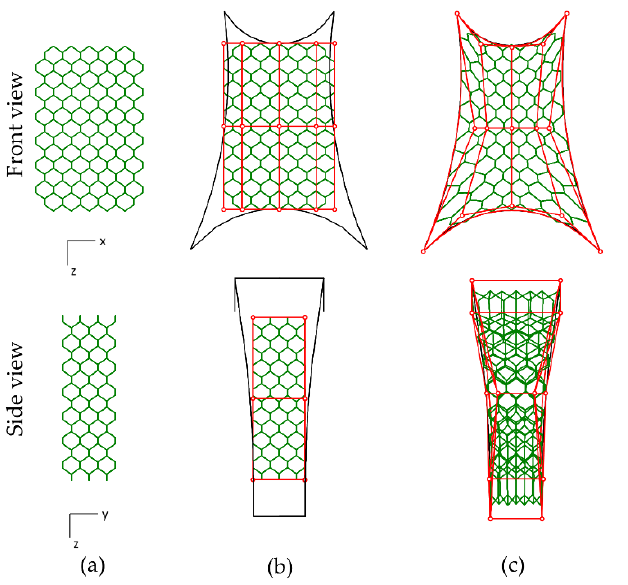
Figure 3. NURBS-FFD approach applied to the diamond lattice structure (green lines) ( a ) via a control cage (red lines) ( b ) to conform the lattice to the design space (black lines) ( c ).